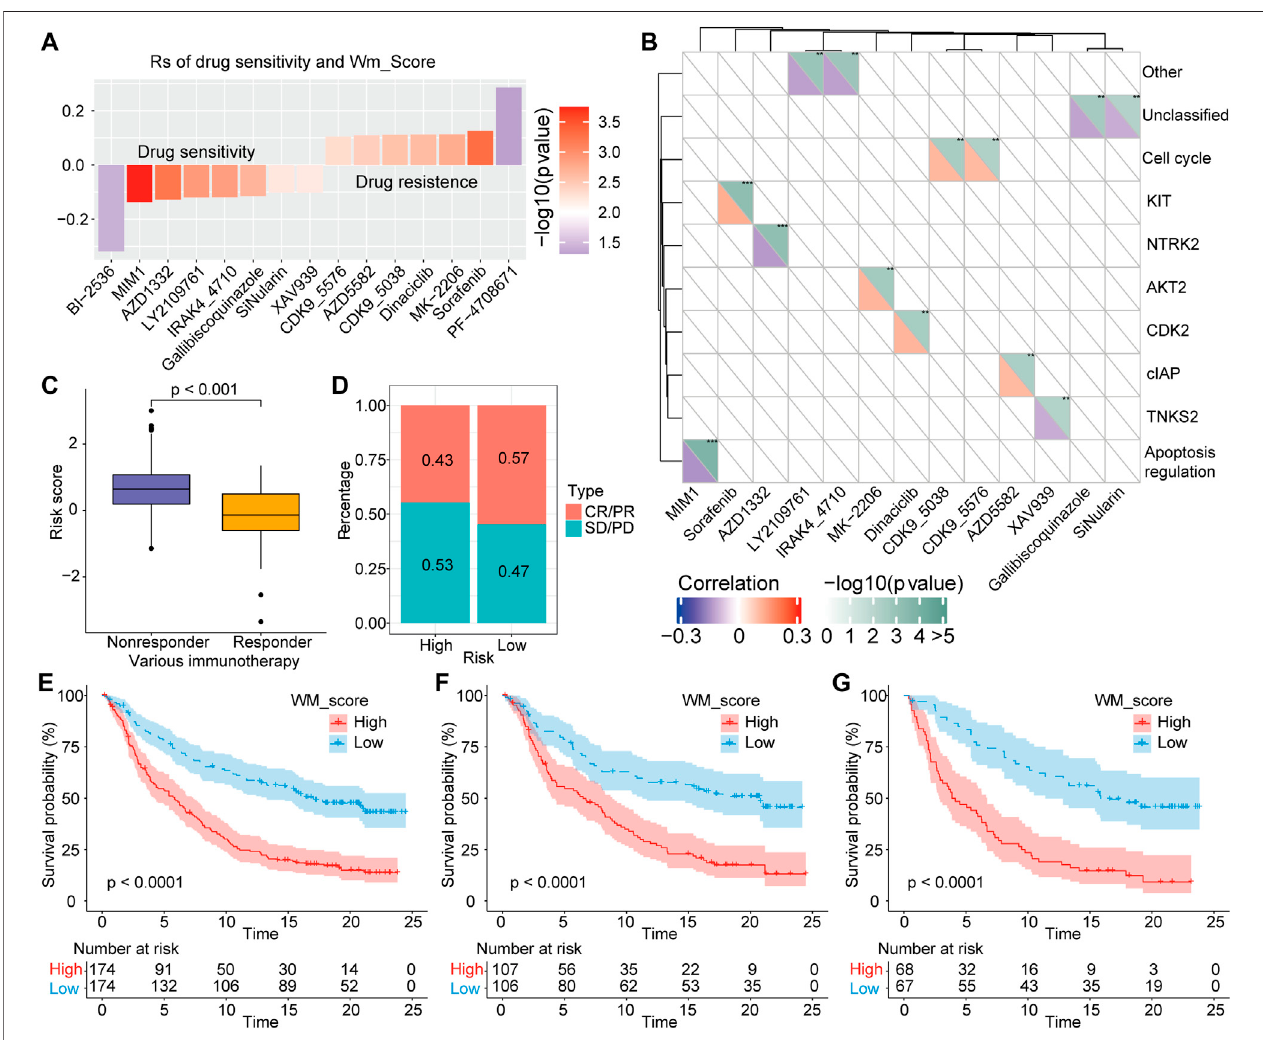
FIGURE 6 | Correlation of scoring model with drug reaction and immunotherapeutic response. (A) . Spearman ’ s analysis was used to determine the correlation between score and drug response in GDSC. (B) . The association between drugs and targeted signaling pathways. (C) . The difference in the score between immunotherapeutic responder in the IMvigor210 cohort. (D) . The percentage of patients with different responses (including SD, PD, CR, and PR) to PD-L1 blockade immunotherapy.E-G.Totalsamples,orStageI+IIsamples,orStageIII+IVsamplesintheIMvigor210cohortallshowedasigni fi cantdifferenceinsurvivalbetween samples with high and low WM-Scores based on survival